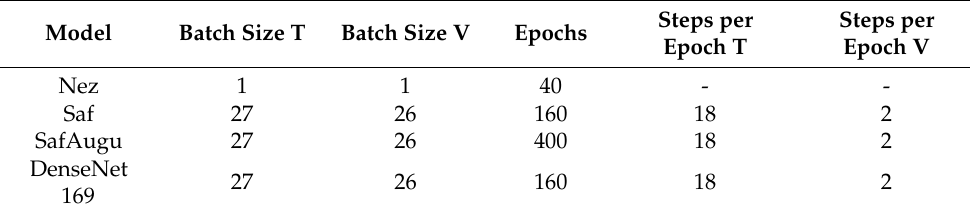
Table 4. The overview of finally selected batch size, number of epochs and steps per epoch for every CNN model to prevent overfitting. Model Batch Size T Batch Size V Epochs